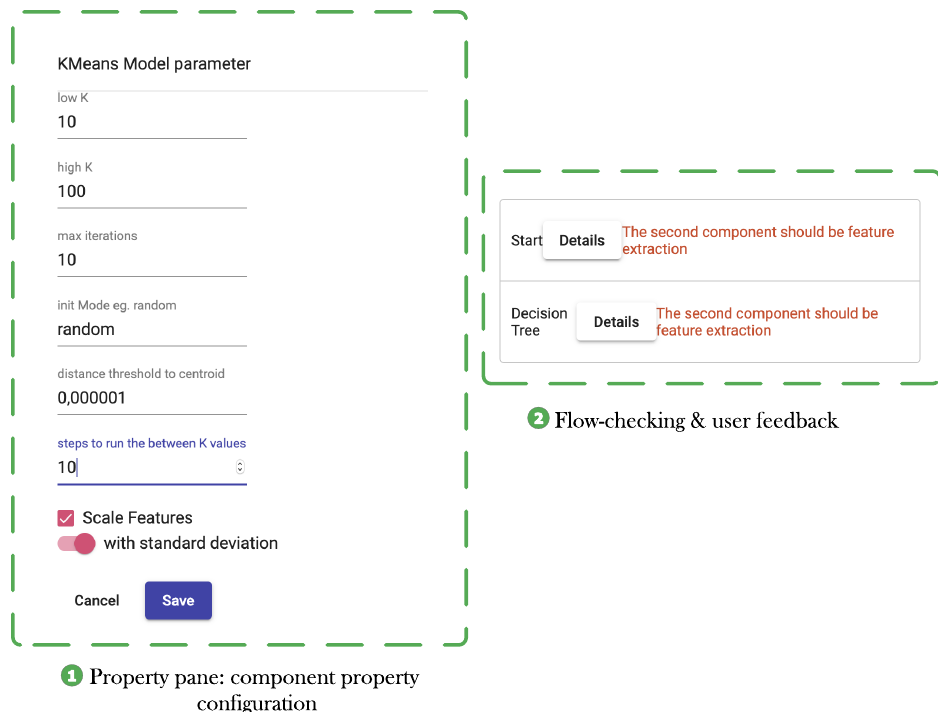
Figure 5. Component property configuration and flow-checking with user